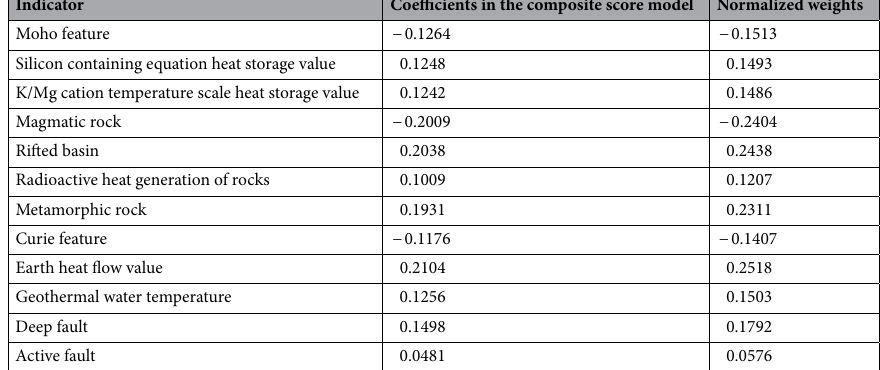
Table 3. Indicator weights calculated by principal component analysis (PCA).